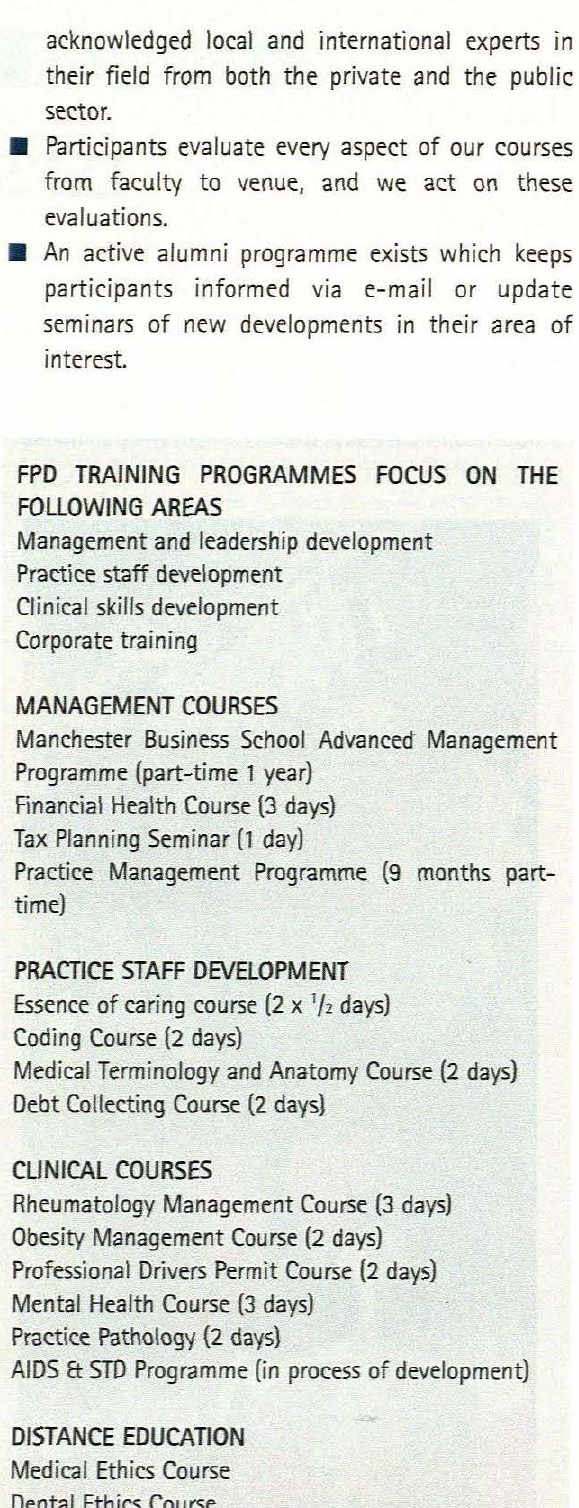
Fig. 1. Student enrolment in the